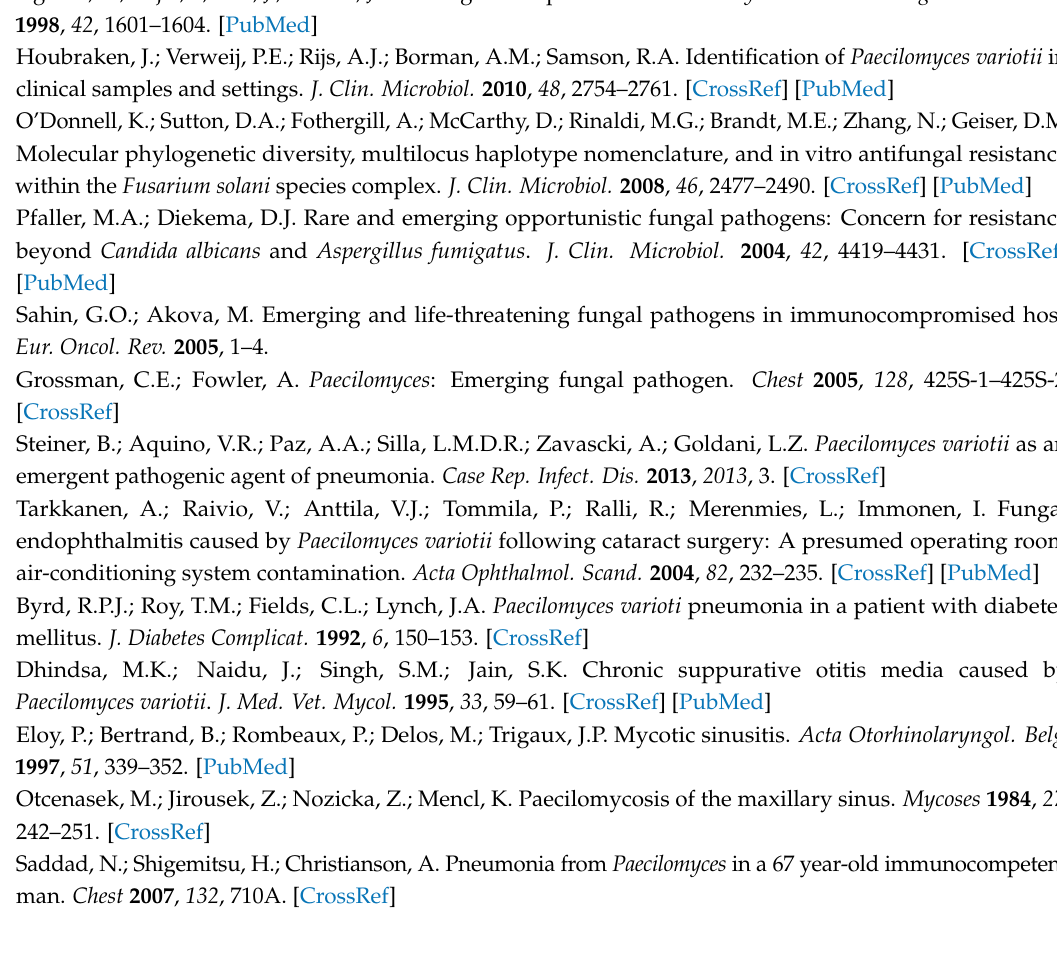
Table S1: Total number of P. variotii strains, Pv19, Pv06, and Pv23 adhered to control and treatment slides before slides were washed with RO water in adhesion assays where ∆ denotes difference between controls and treatments where positive change value implies an increase and negative change value implies a decrease, Table S2: Total number of adhered fungi for each morphotype after exposure to A. striata before slides were washed with RO water in adhesion assays for 3 strains of P. variotii , Pv19, Pv06, and Pv23. NA = non-aberrated, SP = swollen with parallel cell walls, SNPM = swollen with non-parallel cell walls up to the hyphal midpoint, SNPL = swollen with non-parallel cell walls throughout the hyphal length, SNPSC = swollen with non-parallel cell walls in the sub conidial hyphal